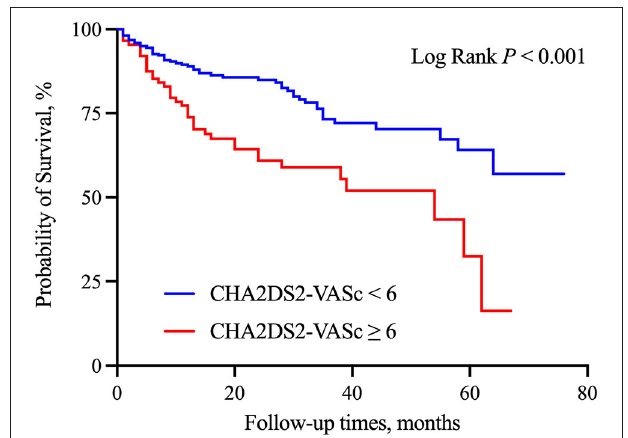
FIGURE 1 | Kaplan-Meier survival curves for all-cause mortality by CHA 2 DS 2 -VASc